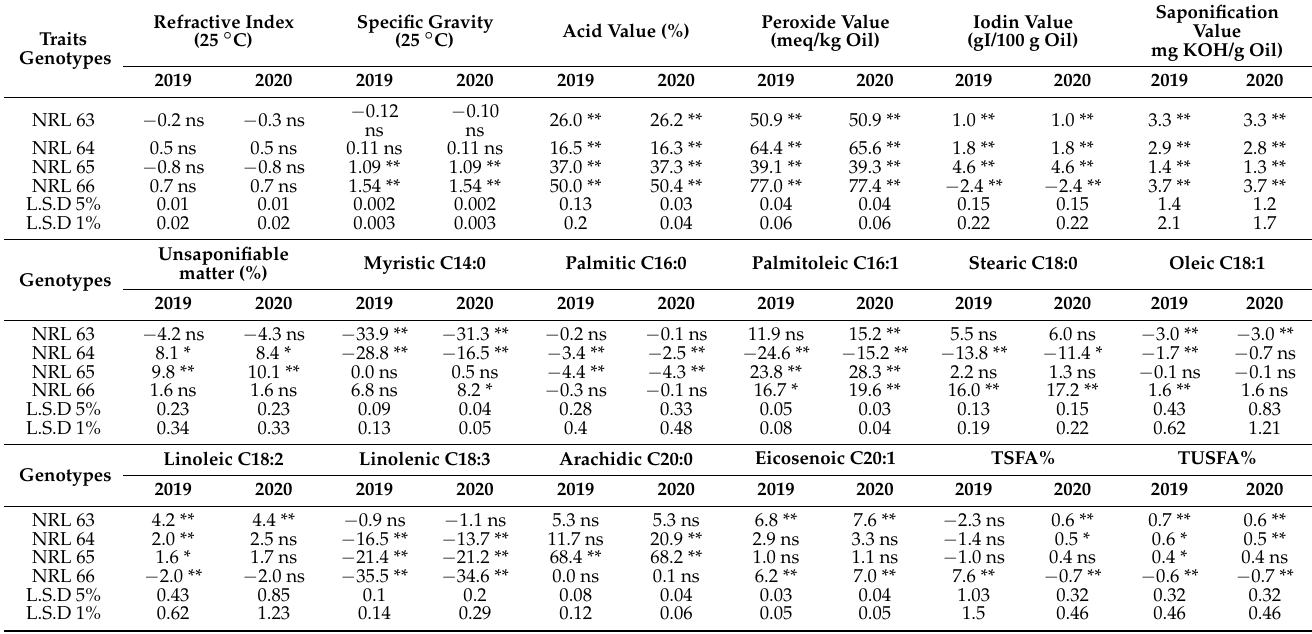
Table 15. Estimates of the percentage of advantage over commercial variety for some physical, chemical properties, and fatty acids profile of stabilized rice bran samples of the studied genotypes during the 2019 and 2020 growing